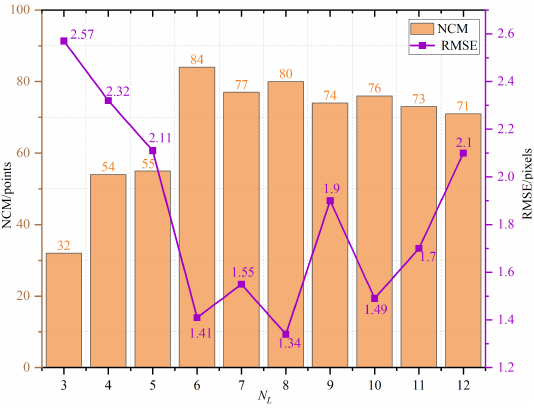
Figure 7. Results of the MoTIF layers